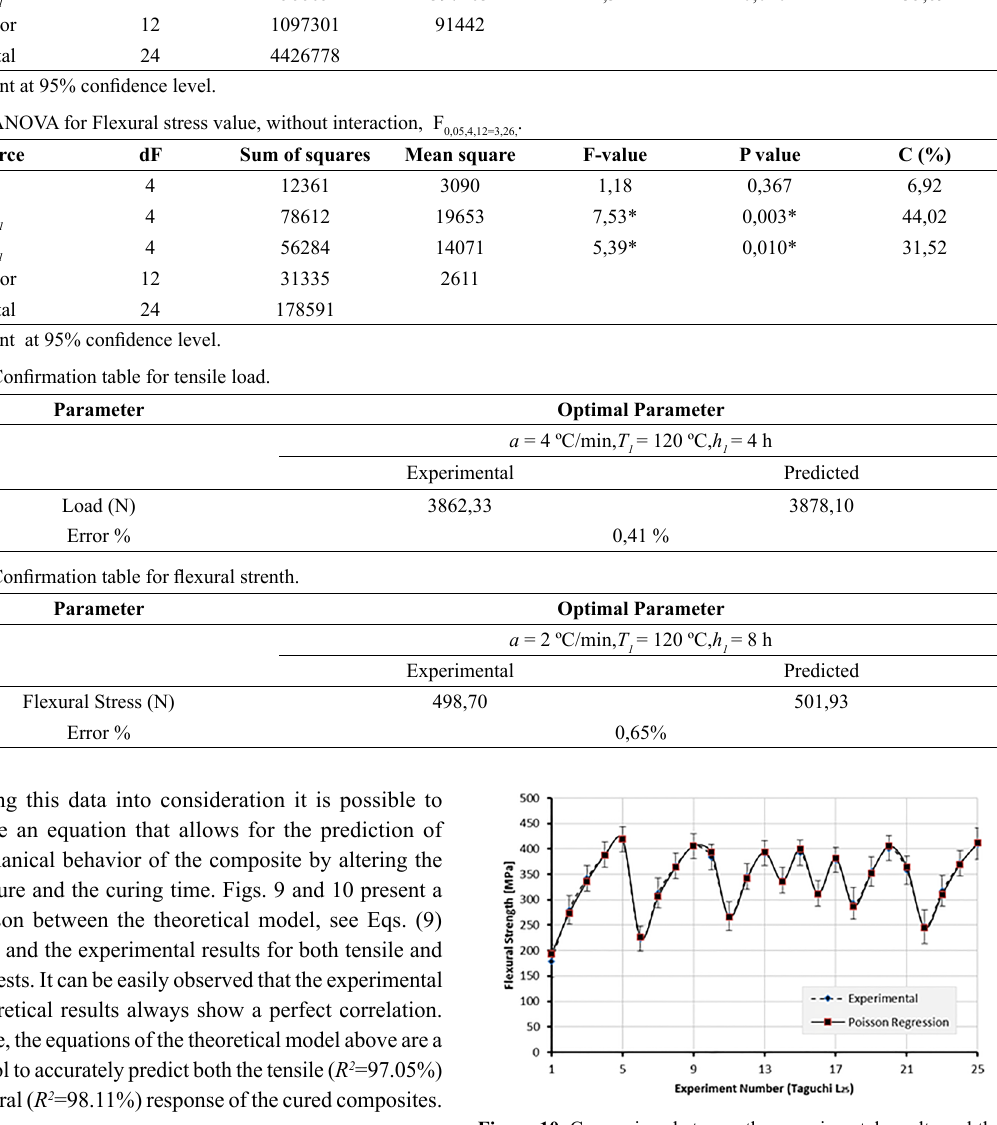
Figure 10. Comparison between the experimental results and the theoretical values of flexural